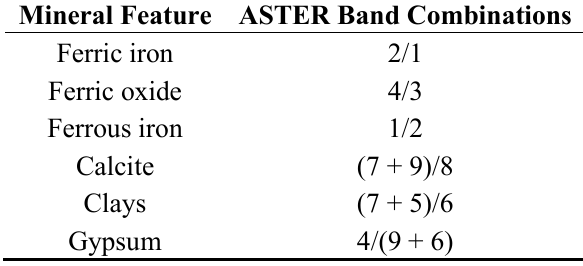
Table 1. ASTER band ratios for enhancing mineral